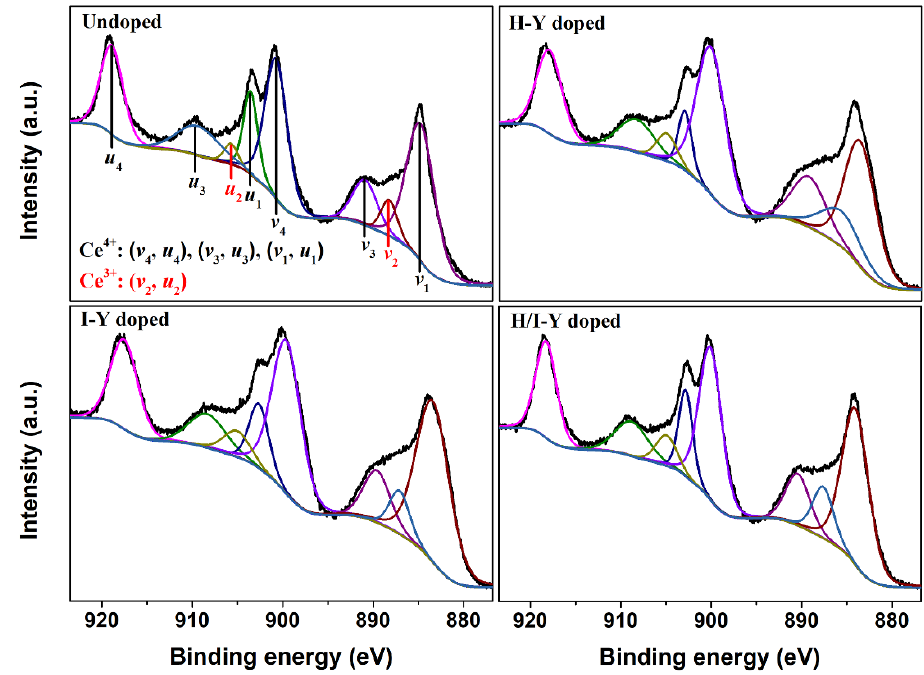
Figure 4. Ce 3d XPS spectra of Undoped and H-Y-, I-Y-, and H/I-Y-doped CeO 2 . In order to understand the effect of Y-doping on oxygen ions in CeO 2 crystals, the O 1s XPS regions of the Undoped CeO 2 and H-Y-, I-Y-, and H/I-Y-doped CeO 2 were recorded and fitted, as shown in Figure 5. The O 1s XPS spectrum of the Undoped CeO 2 was curve- fitted into two peaks: one peak, labeled as α , at ~529.2 eV, could be attributable to the lattice oxygen species; the other peak, labeled as β , at ~531.4 eV, could be attributable to the chemisorbed oxygen species and/or weakly bonded oxygen species related to the oxygen vacancy ( V O ) defects. For the O 1s spectra of the H-Y-, I-Y-, and H/I-Y-doped CeO 2 , a new peak labeled as γ , at~528.5 eV, was curve-fitted, which could be assigned to the O-Y species. In addition, the relative oxygen vacancies ratio (labeled as [ V O ] XPS ) could be quantified using Equation (2), and the results are shown in Table 1.